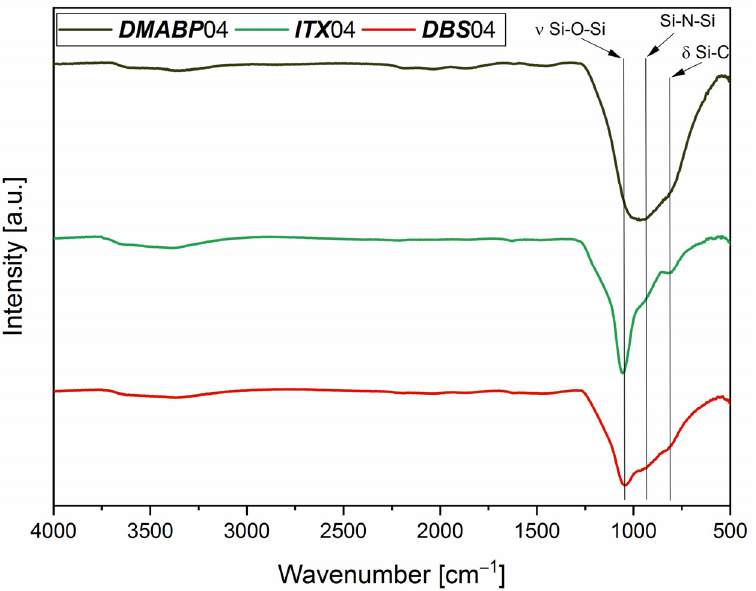
Figure 13. FTIR spectra of amorphous DMABP 04, ITX 04, and DBS 04 pyrolyzed in nitrogen at 950 °C.